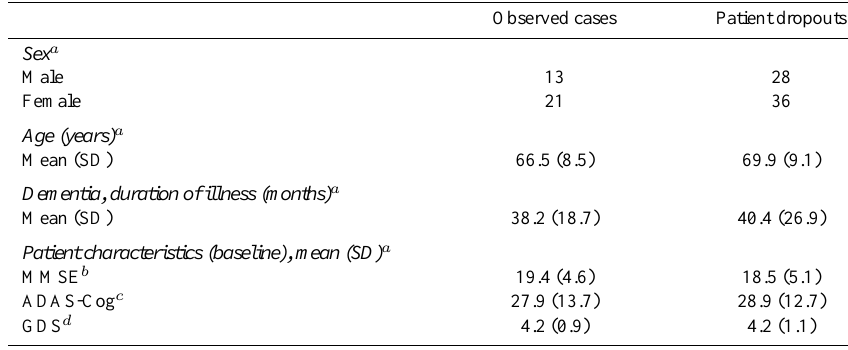
Table 2 Demographics and characteristics of study patients (observed cases) and patients discontinuing